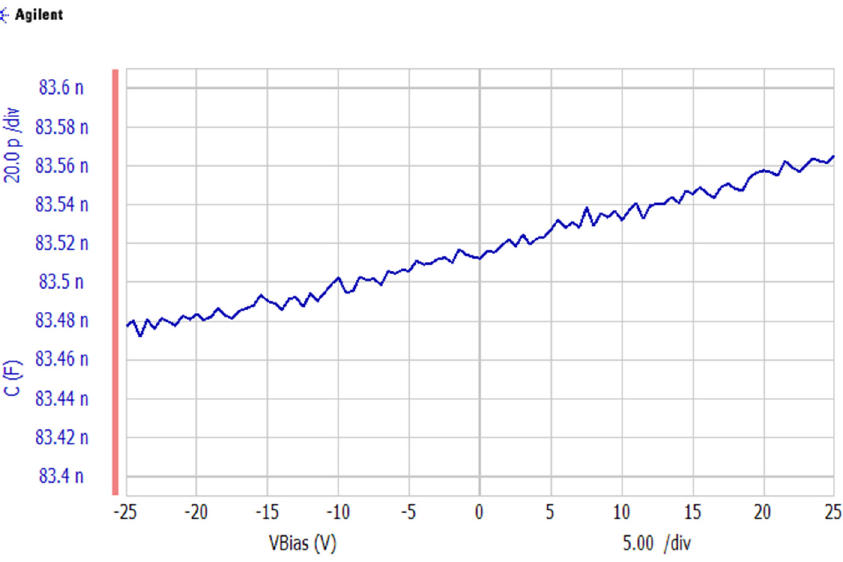
Figure 5. Measured C-V curve when applying voltages ranging from − 25 V to +25 V at room temperature (25 ℃(cid:4667) .